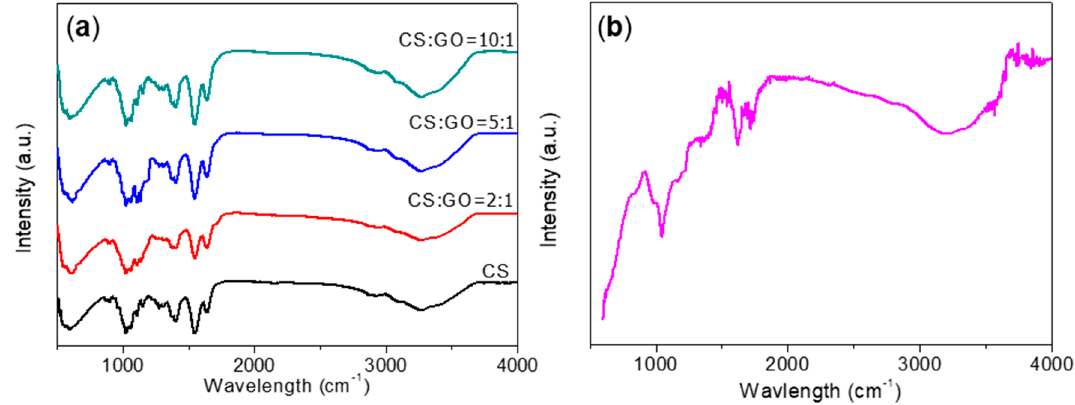
Figure 4. Fourier transform infrared (FTIR) spectra for ( a ) CS and CS:GO nanocomposites, ( b ) GO powder.